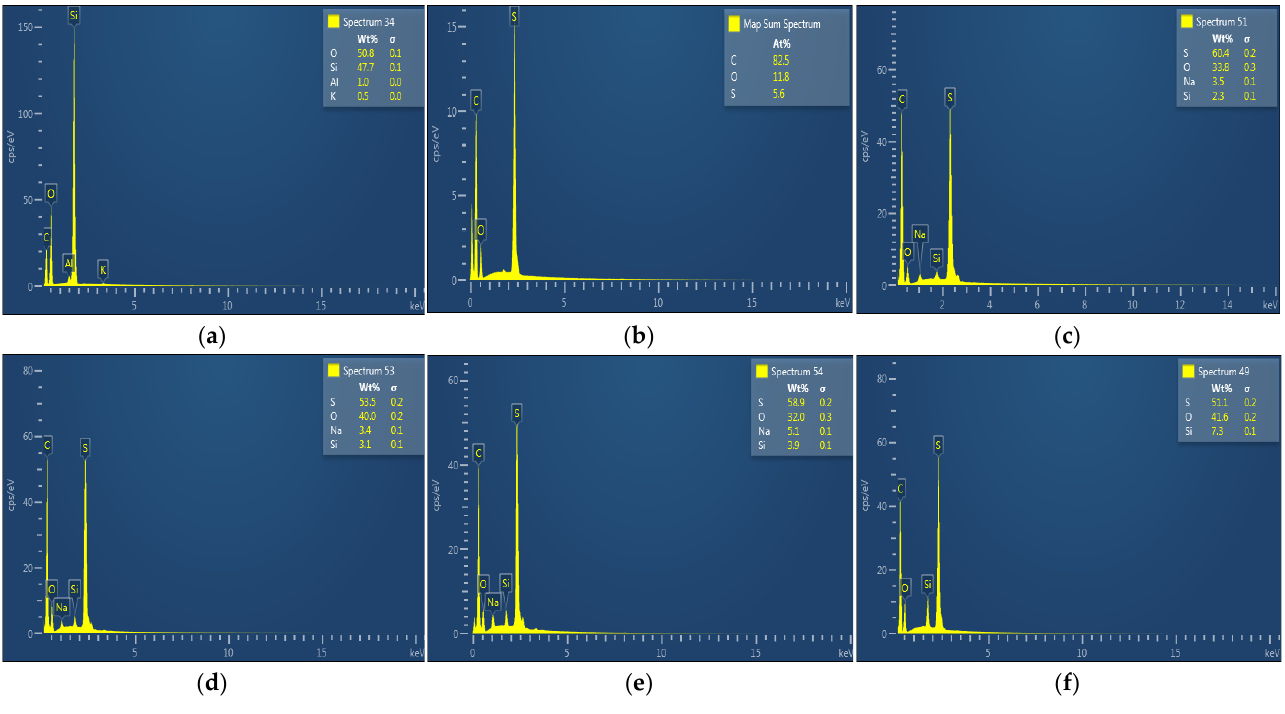
Figure 7. EDX spectra of ( a ) ZSM-22, ( b ) PES, ( c ) 0.3 wt.% C60-ZSM-22/PES, ( d ) 0.3 wt.% F60-ZSM- 22/PES, ( e ) 1.0 wt.% C60-ZSM-22/PES, and ( f ) 1.0 wt.% F60-ZSM-22/PES membrane materials.